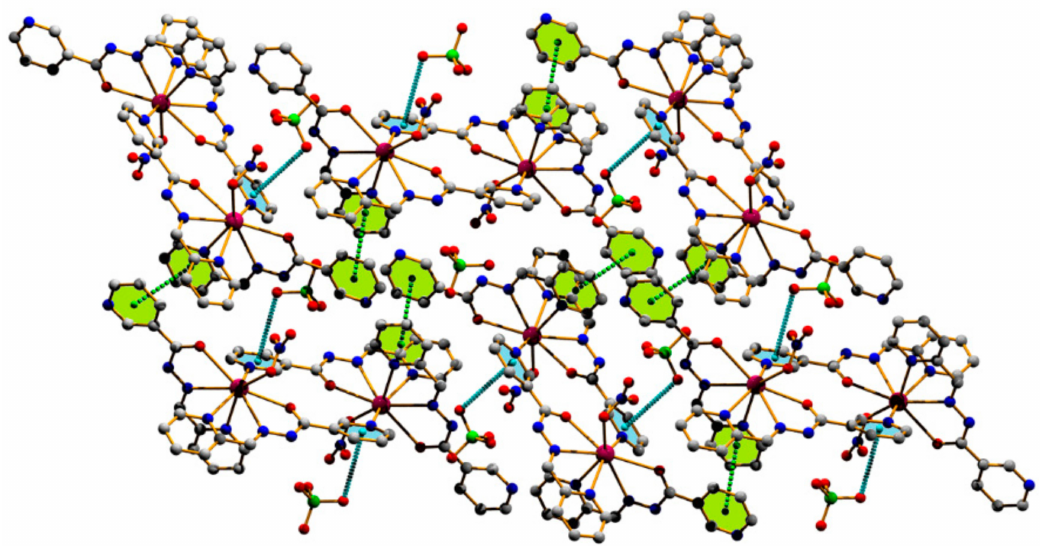
Figure 4. Supramolecular network of ( 1 ) in (011) plane through anion ··· π and π - π